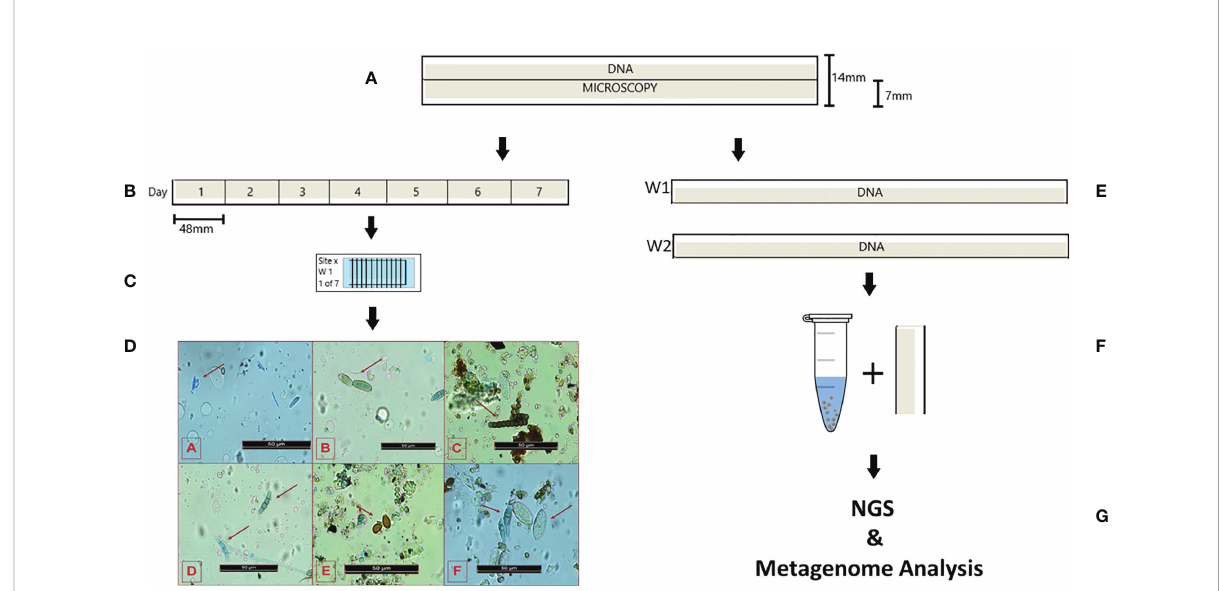
FIGURE 2 Schematic summarizing the preparation of the spore trap tapes for microscopy and metagenomic analysis. (A) the full tape was split longitudinally and divided ½ for microscopy and ½ for DNA extraction; (B) the microscopy half was divided into 7 sections (48 mm wide), each representing one day of collection; (C) tape sections were stained with solution of 10% Trypan-blue-lactophenol 90% colorless glycerin, and mounted on microscope slides, which were segmented in 12 parts 2mm wide. Each 2mm section represents 2 hours of collection; (D) Representative images of different fungal spores from the spore trap tape microscope slides. Red arrows indicate: [A] Zymoseptoria spp. ascospores, [B] Cladosporium spp., [C] Torula herbarum [D] Fusarium spp. Ascospores, [E] Puccinia spp. [F] Alternaria spp. (left), Blumeria graminis (right); (E) Two half tapes from two consecutive weeks of collection were used for monthly DNA extraction; (F) tape sections were used for DNA extraction using the Qiagen DNeasy Soil Kit and 400 – 600 µm acid – washed beads; (G) DNA extracted was sent for NGS and DNA reads analyzed for metagenomic of fungal